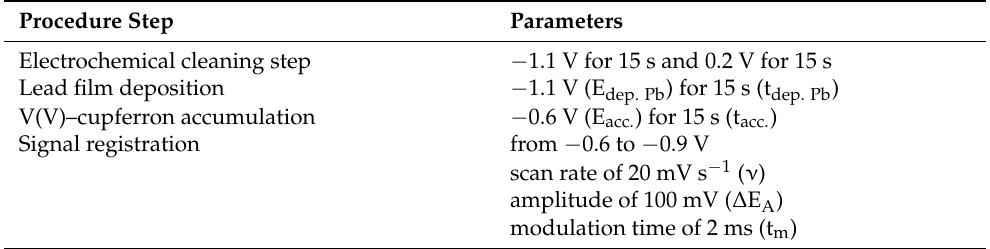
Table 1. The DPAdSV parameters under optimized conditions of the V(V) analysis at the